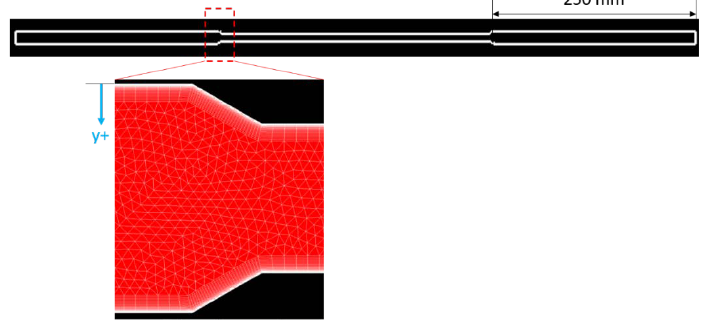
Figure 6. Example of a half 3D model used in the numerical simulation.